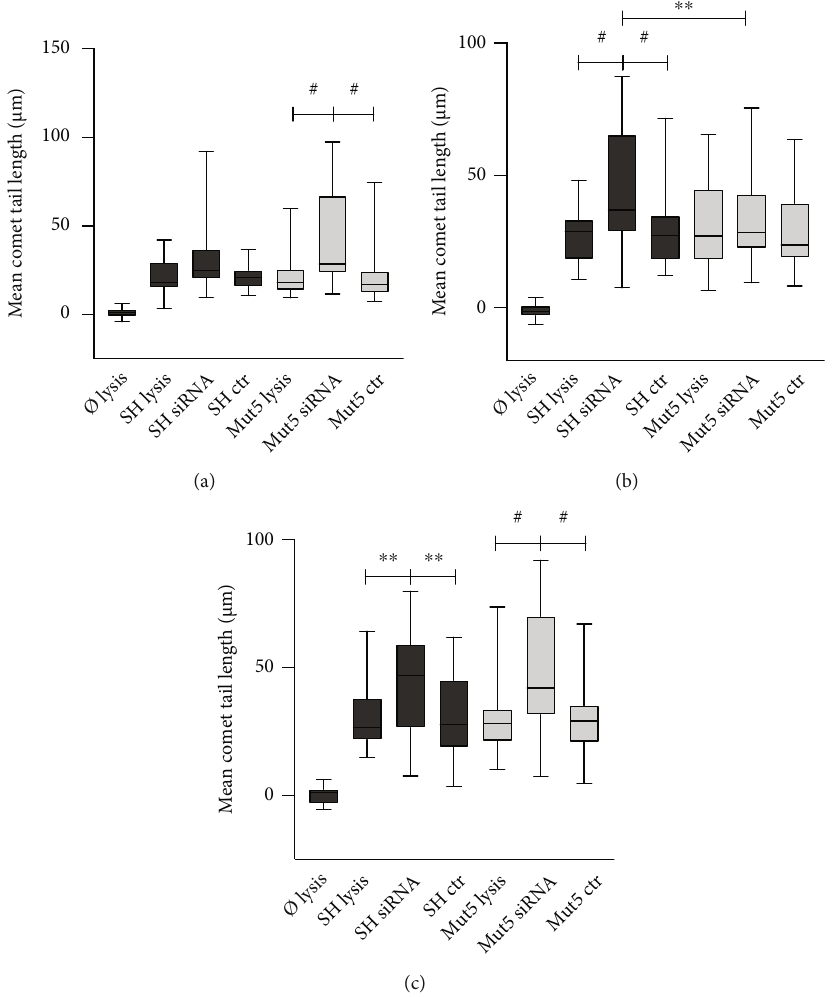
Figure 9: Comet tail lengths (in μ M) or DNA double-strand breaks (DSBs) in SH-SY5Y cells (SH) and Mut5 clone after siRNA inhibition, or not (lysis), of ADAM10/ α -secretase (a, 120pmol siRNA) and of BRCA1 (b, 120pmol and c, 240pmol siRNA). Scrambled sequences were used as negative controls (ctr). We observed a statistically signi fi cant increase in DSBs in the Mut5 clone and not in the SH cells with the ADAM10 siRNA and in the SH cells more than in the Mut5 clone with the BRCA1 siRNA. Number of cells measured: 30 < n < 32 . One-way ANOVA with Bonferroni multiple comparisons test: ∗ p < 0 : 05 ; ∗∗ p < 0 : 002 ; # p < 0 : 0002